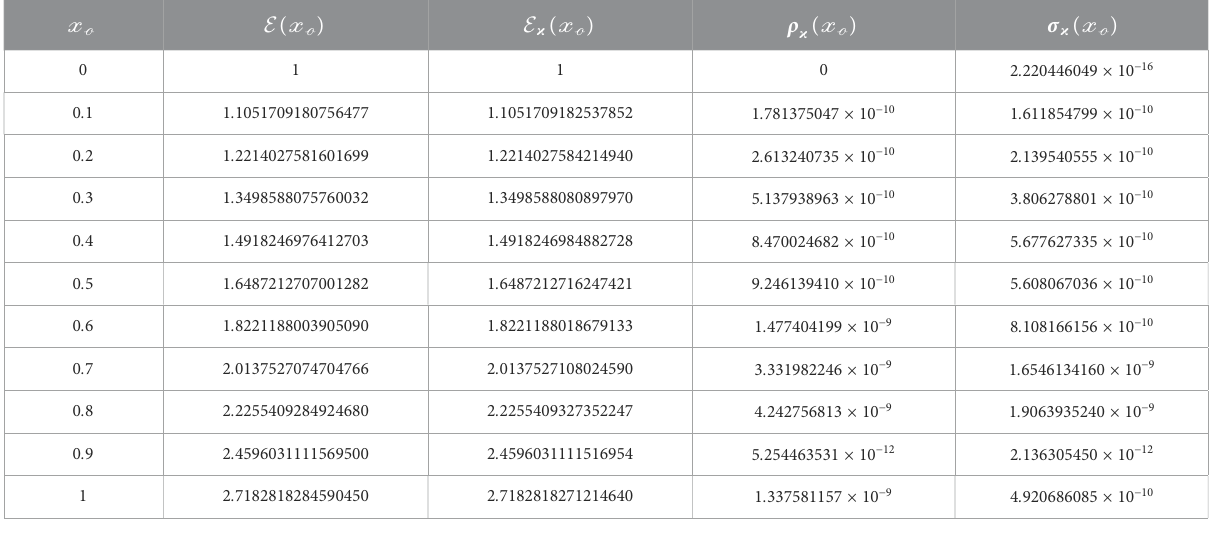
TABLE 2 Associated RKHA scores for application 2 with 8 (cid:2) 101 , when ( α , β ) (cid:2) ( 1 / 3 , 3 / 4 ) . 